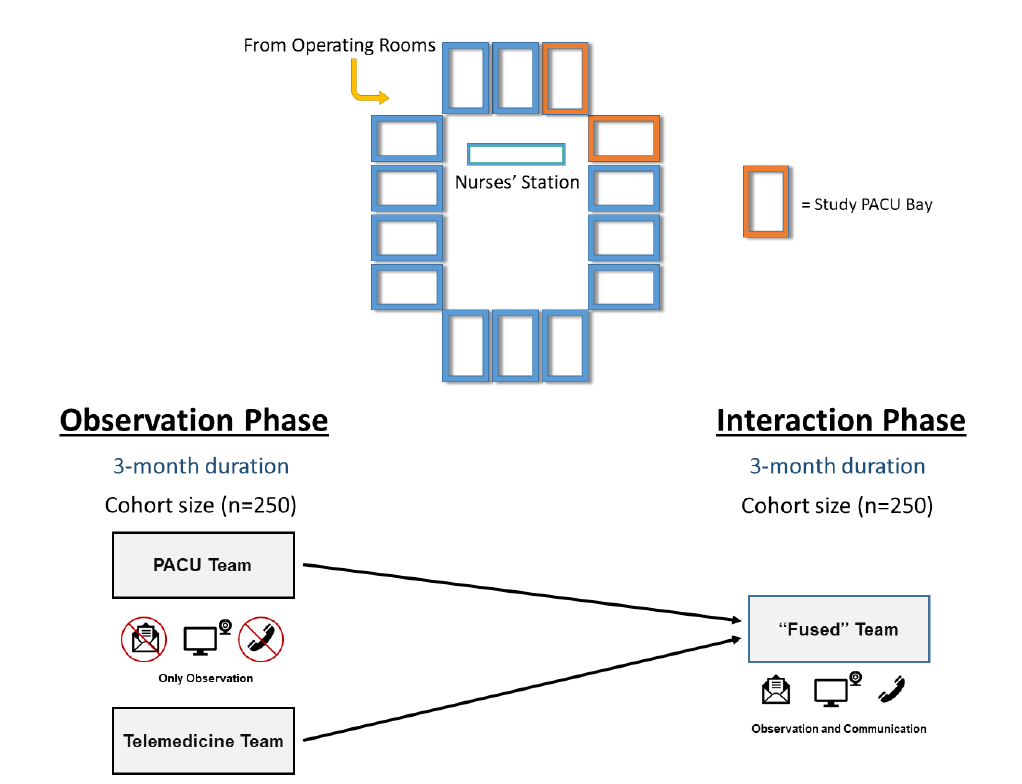
Figure 4. Allocation of sample size and post-anesthesia care unit (PACU) layout for proof-of-concept